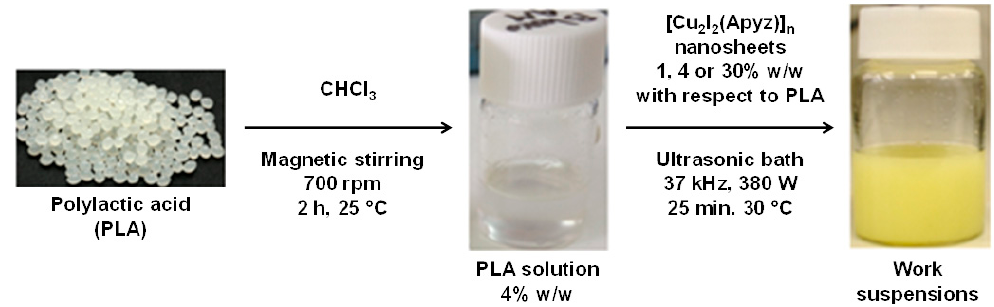
Figure 3. Scheme of the process that leads to the obtainment of homogeneous suspensions of [Cu 2 I 2 (Apyz)] n @PLA . [Cu 2 I 2 (Apyz)] n @PLA .